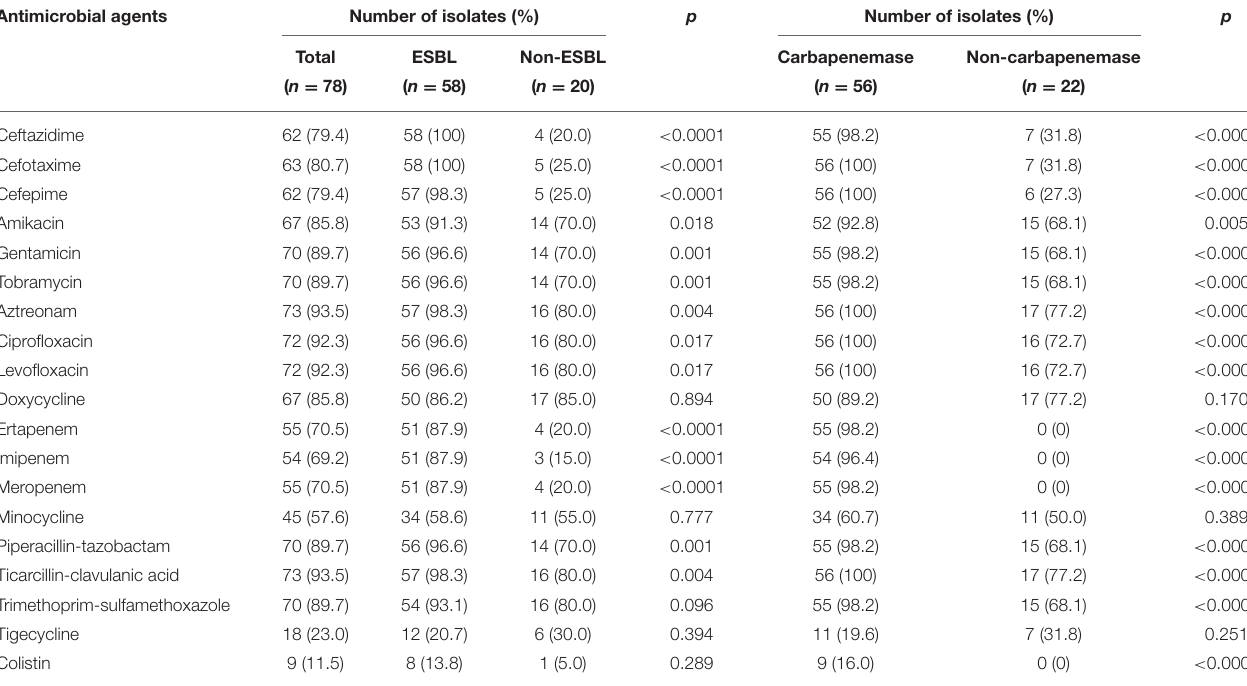
TABLE 1 | Rates of antibiotics resistance among K. pneumoniae bloodstream infections (BSIs) in intensive care unit (ICU) patients. Antimicrobial agents Number of isolates (%) p Number of isolates (%)